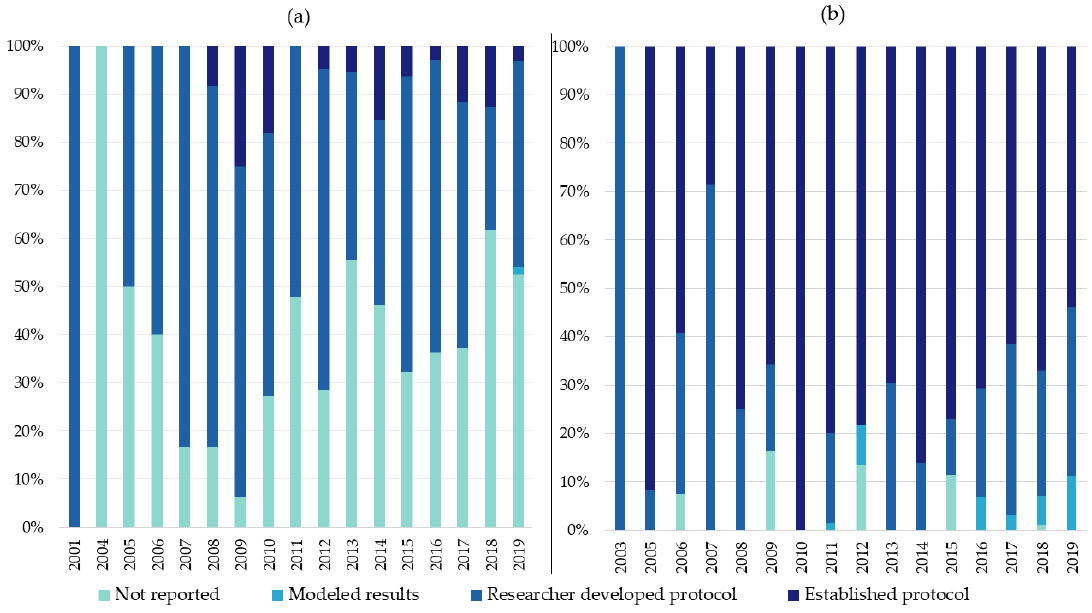
Figure 12. Breakdown of protocols used by year in hydrologic studies ( a ) and contaminant transport and fate studies ( b ).